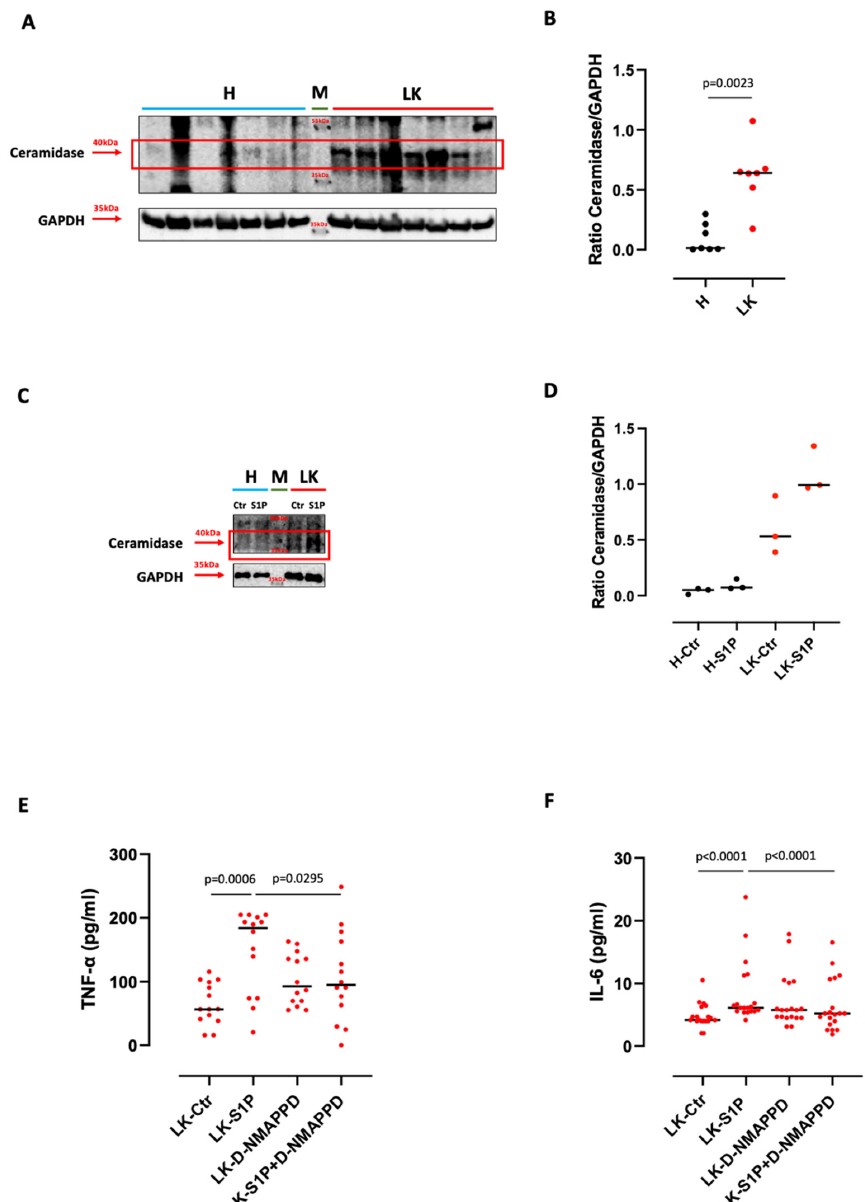
Figure 3. S1P-induced pro-inflammatory cytokine release was ceramidase dependent. ( A ) Western blotting shows that healthy volunteers (H)-derived PBMCs expressed lower levels of ceramidase active form (40 kDa) compared to lung cancer (LK)-derived PBMCs. GAPDH was used as a loading control. The experiment was repeated three times. M refers to the protein molecular weight marker. ( B ) Ceramidase active form expression analysis was performed by ImageJ software (NIH, USA) and expressed as a ratio between ceramidase and GAPDH. ( C ) One-hour S1P-stimulated LK-derived PBMCs over-expressed the ceramidase in its active form (40 kDa) compared to control (Ctr) and to H-isolated PBMCs. GAPDH was used as a loading control. The experiment was repeated three times. M refers to the protein molecular weight marker. ( D ) Ceramidase active form expression analysis was performed by ImageJ software (NIH, USA) and expressed as a ratio between ceramidase and GAPDH. Ceramidase inhibition by means of D-NMAPPD (5 µM) significantly reduced the release of TNF- α ( E ) and IL-6 ( F ) from LK-derived PBMCs, after S1P (10 nM) addition. n = 14 LK matched-pair samples were tested for TNF- α ( E ) and n = 19 matched-pair samples were tested for IL-6 ( F ). Data are represented as scatter dot plots indicating the median (confidence interval = 95%). Statistical differences were assessed by means of a two-tailed Wilcoxon matched-pairs signed rank